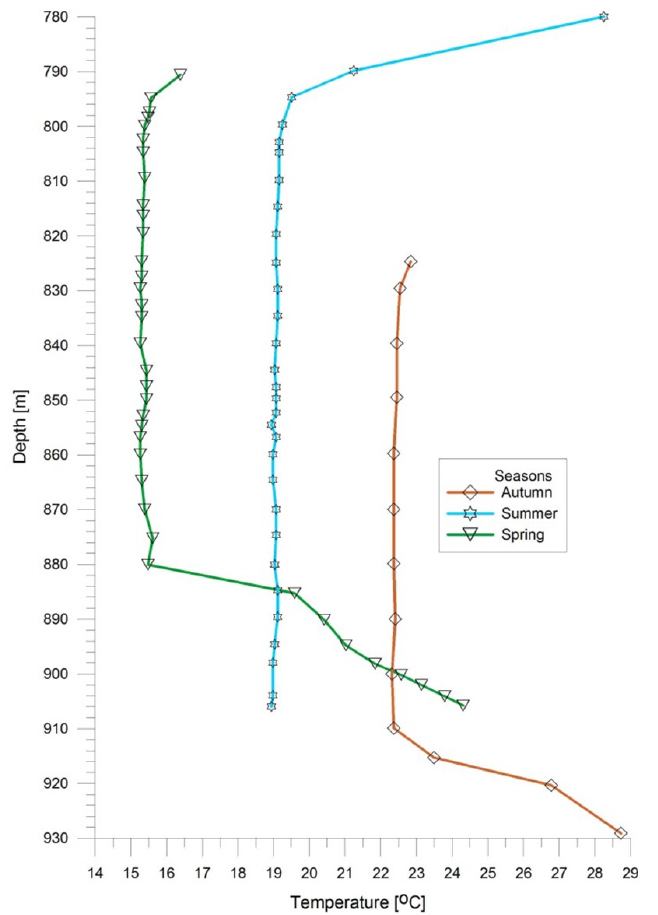
Figure 2. Brine temperature distribution in the cavern during leaching applying direct circulation method